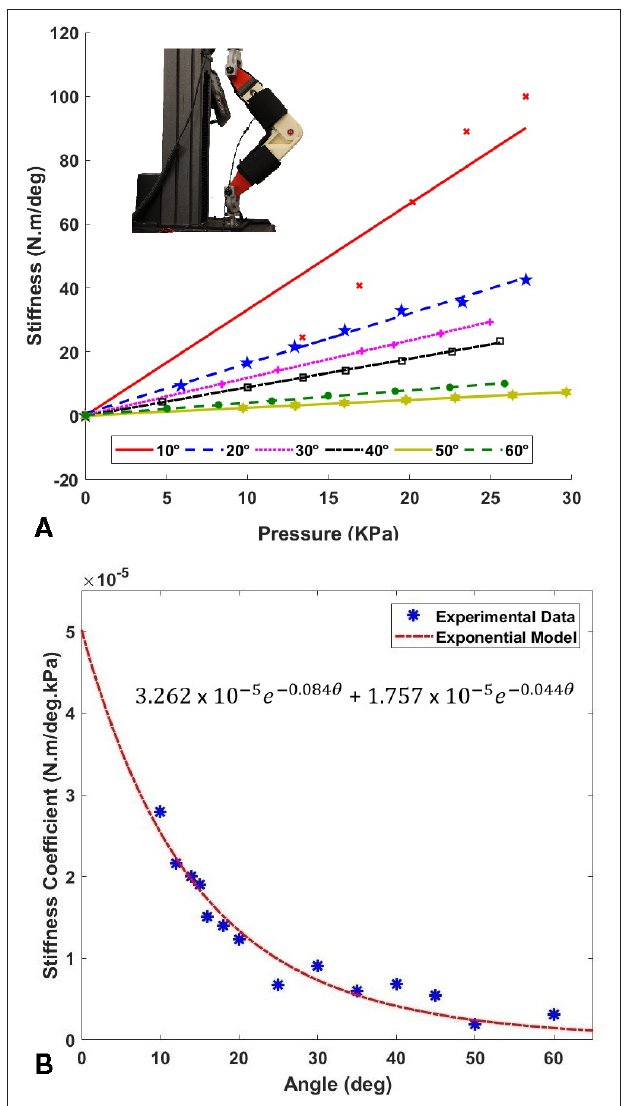
Figure 6 | (a) Pressure ( kPa ) vs Stiffness (N.m/deg) of the inflatable actuators at varying angles. Testing setup mounted on a universal testing machine is shown in the inset. (B) Coefficient of stiffness K